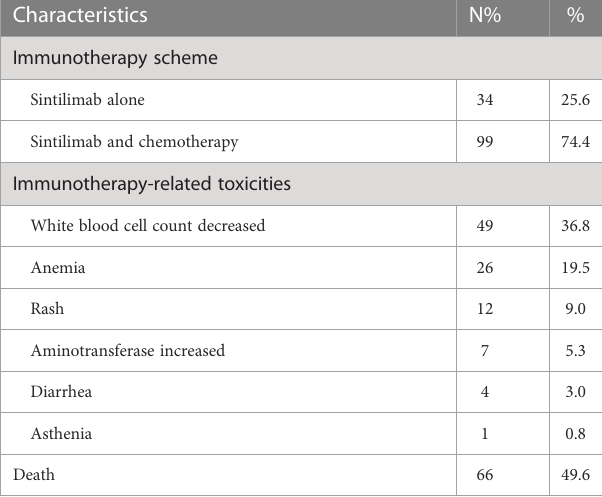
On multivariate analysis, the gender, age, TNM stage, tumor location PD-L1 expression, and the number of lines of previous systemic therapies were not indicative of progression-free survival and overall survival, and previous radiotherapy within 3 months was signi fi cantly related to longer PFS and OS (p < 0.05) (Table 2). Patients who had